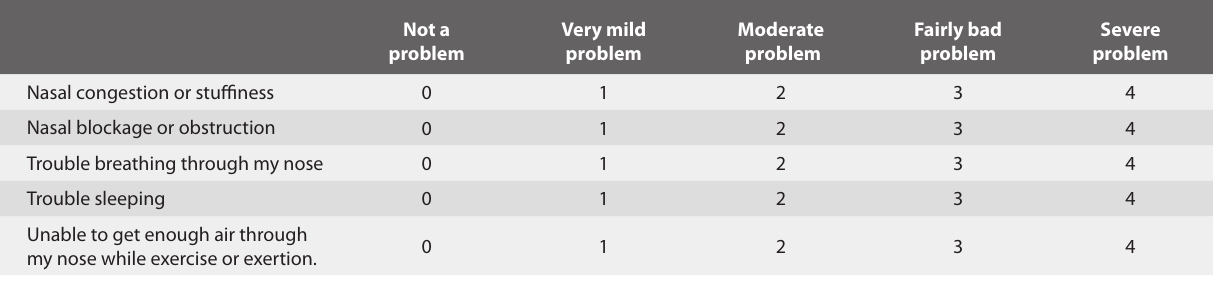
Table 1. Nose score (nasal obstruction symptoms evaluation scale) (8) using a